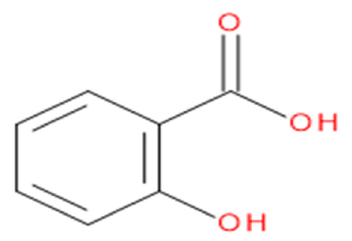
Figure 1. Chemical structure of salicylic acid.